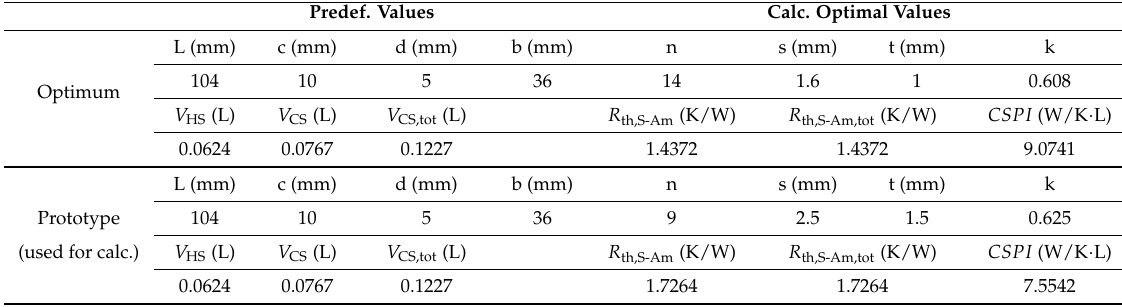
Table A5. Performance indices and parameter values that result from the optimization of the heat sink of the SR (geometry with single-sided base plate, cf. Figure 11). Top inset: result of the optimization, bottom inset: heat sink used in the final prototype converter.